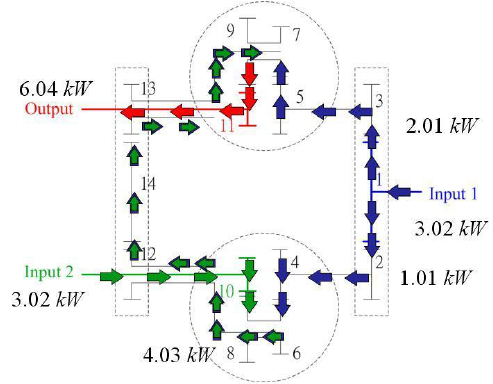
Figure 15. Power flow analysis.